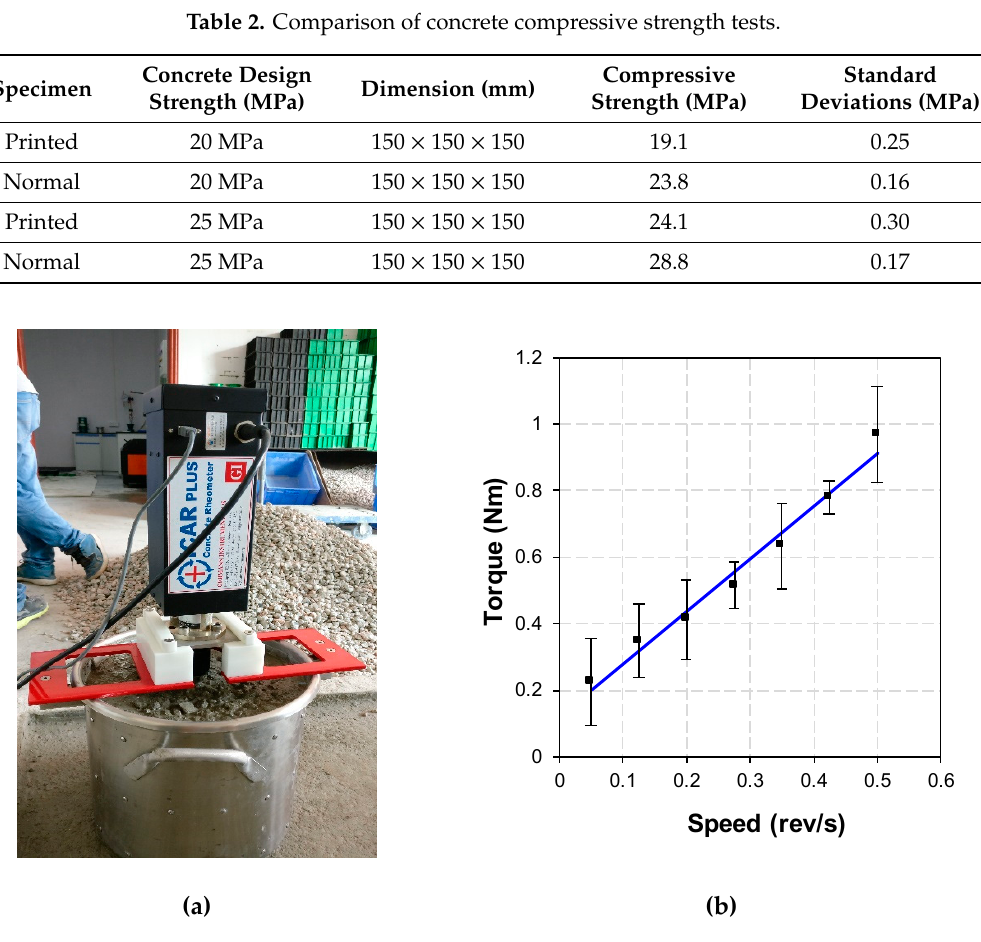
Figure 6. Rheological test of print ready-mixed concrete. ( a ) ICAR rheometer and ( b ) Relationship between torque and rotational velocity.